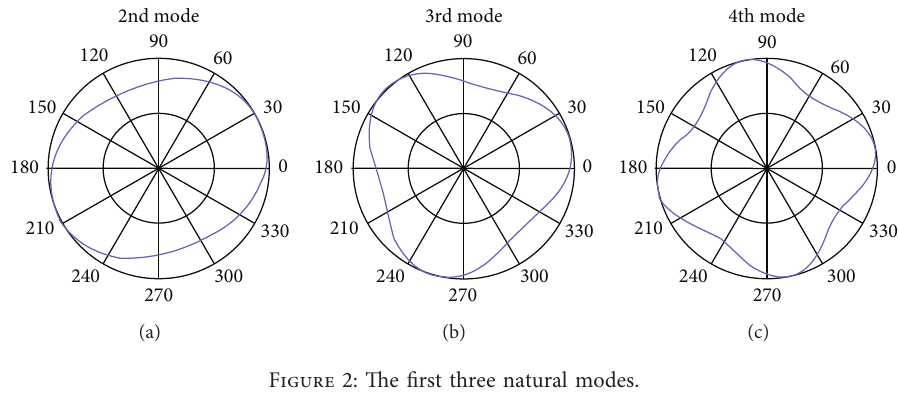
Figure 2: The first three natural